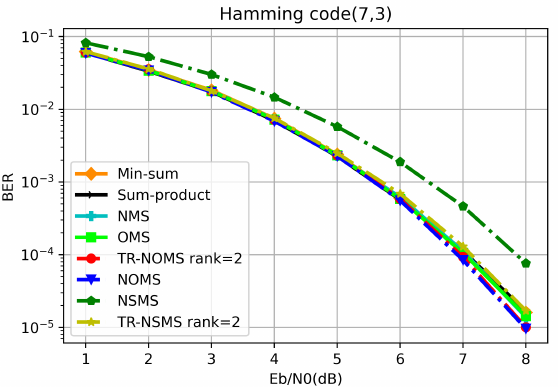
Figure 7. BER performance of TR-NOMS, TR-NSMS, NOMS [22] and NSMS algorithms for Hamming code.